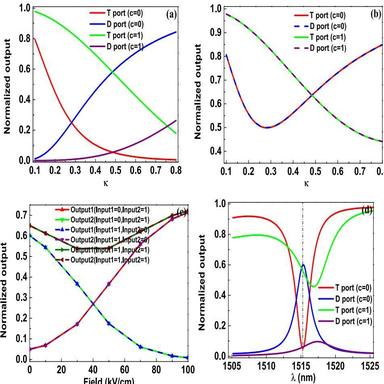
Normalized output power at all ports of the EA MRR based Fredkin gate versus (a) the coupling coefficient between ring and bus waveguide, with Input1 = 0, Input2 = 1 with c = 1 as 70 kV/cm, λR = 1515.27 nm, (b) coupling coefficient between ring and bus waveguide, with Input1 = 1, Input2 = 1 with c = 1 as 70 kV/cm, λR = 1515.27 nm, (c) as a function of applied field at different (Input1,Input2) combinations. (d) wavelength, with Input1 = 0, Input2 = 1 with c=1 as 70 kV/cm and κ = 0.5 (Dotted line shows λR =